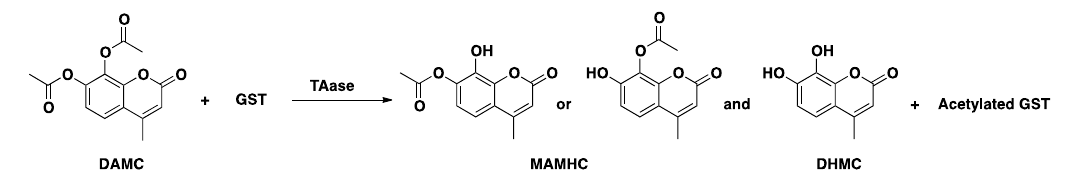
Figure 2. TAase catalyzed reaction.